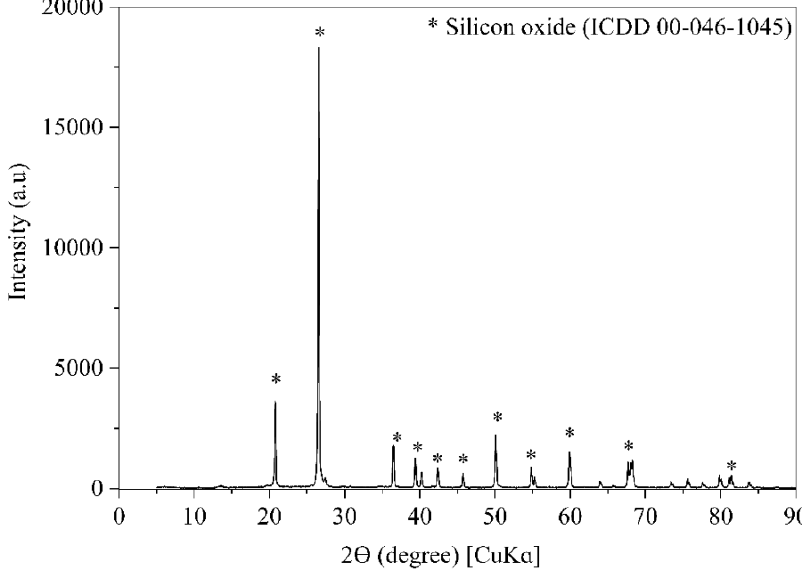
Figure 3. XRD pattern of OSW.